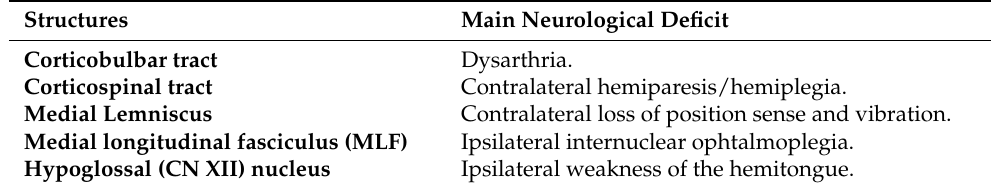
Table 4. Structures involved in MMI and corresponding neurological deficit (modified from [10])